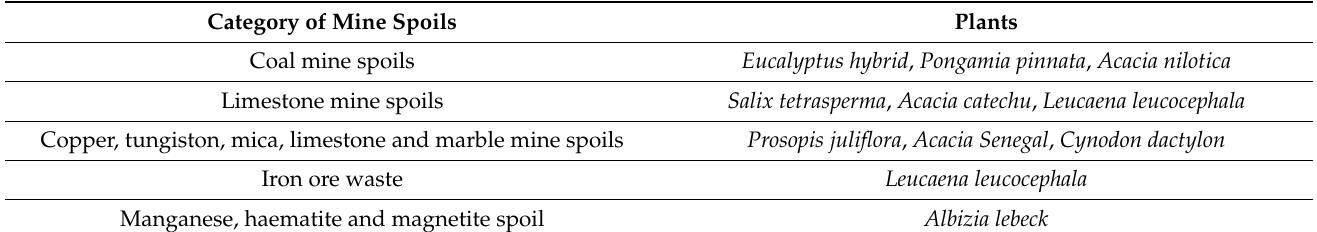
Table 9. Examples of plants involved in the reclamation of mining